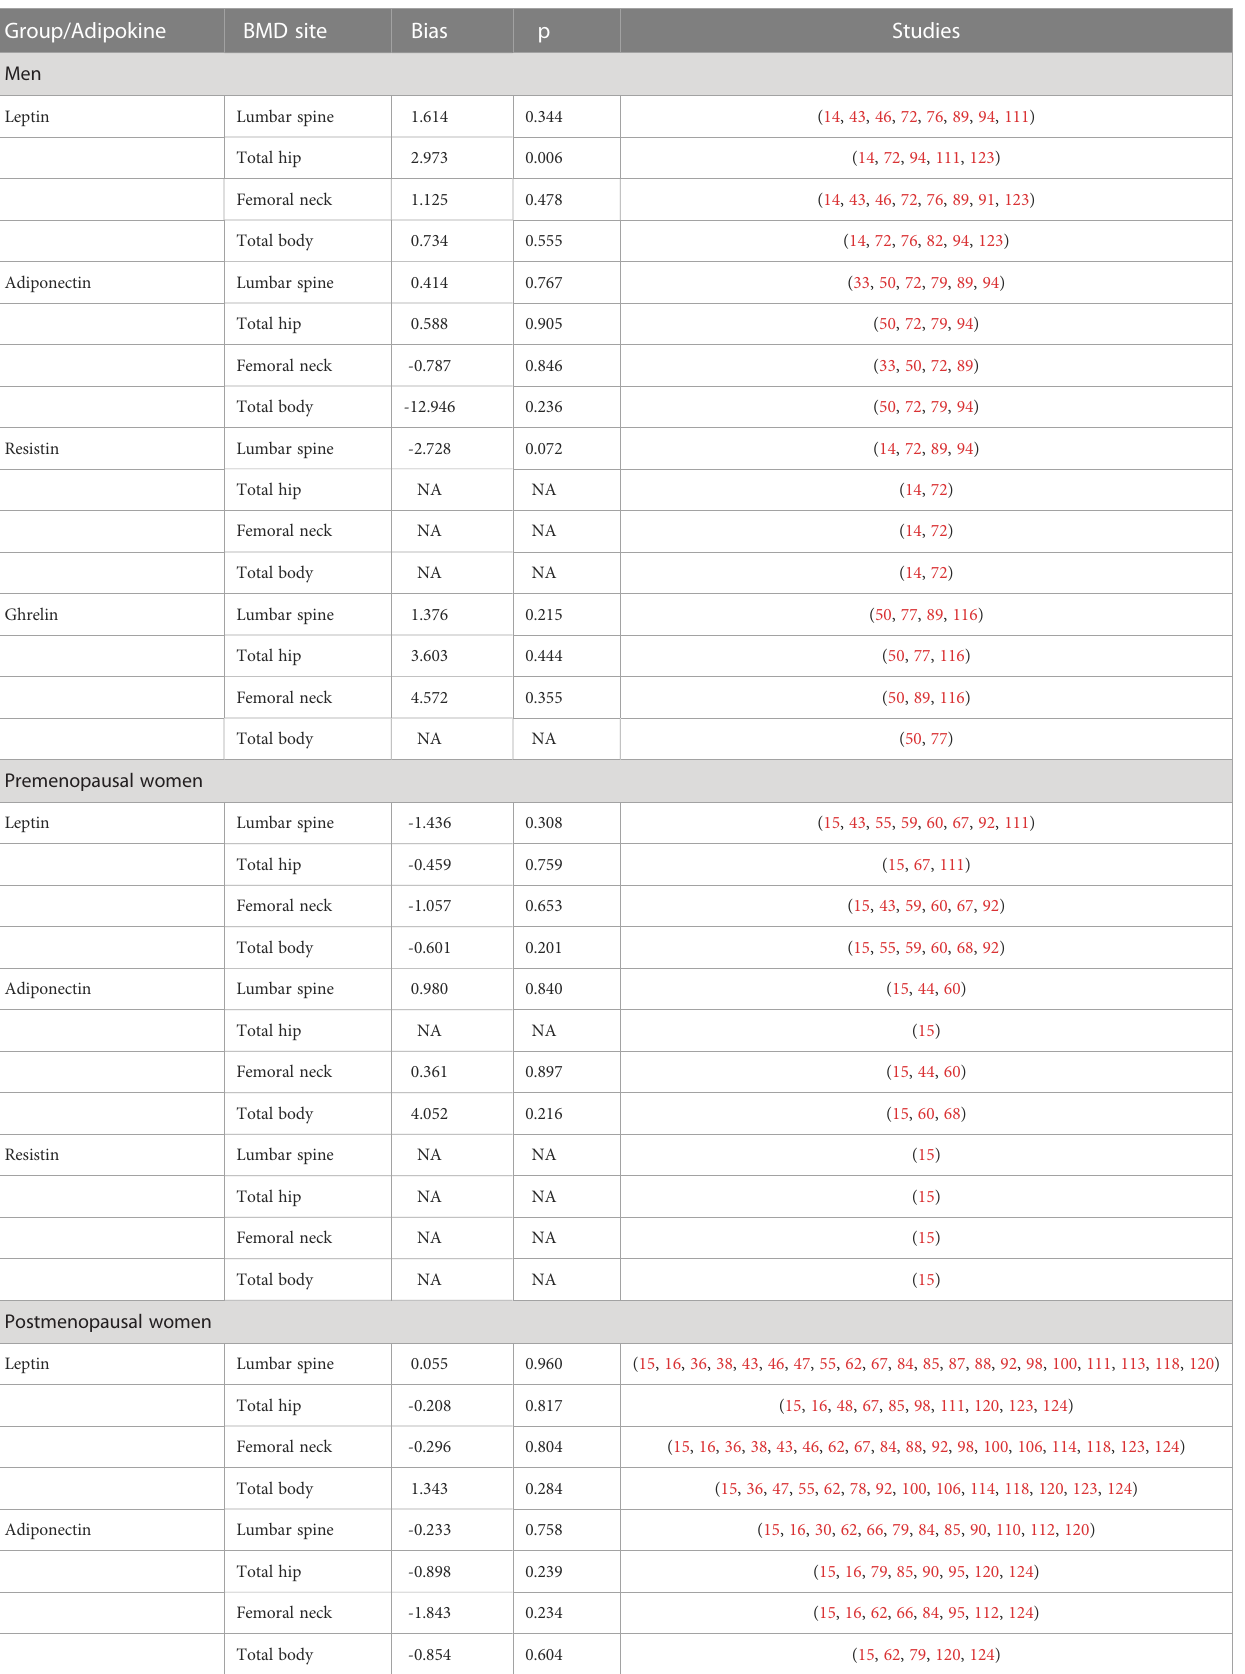
TABLE 2 Summarized results of the Egger ’ s